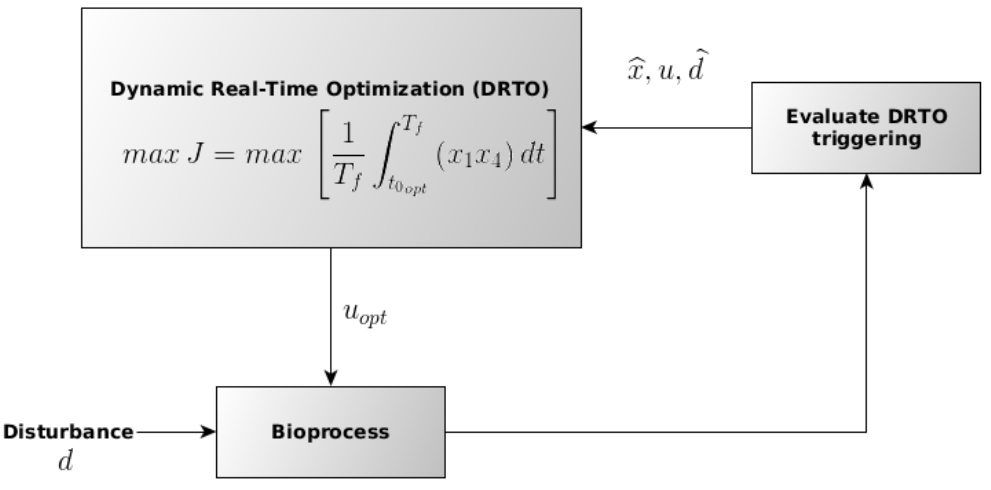
Figure 3. Schematic representation of the procedure employed for the DRTO execution during the batch. Adapted from Ochoa et al. (2010)